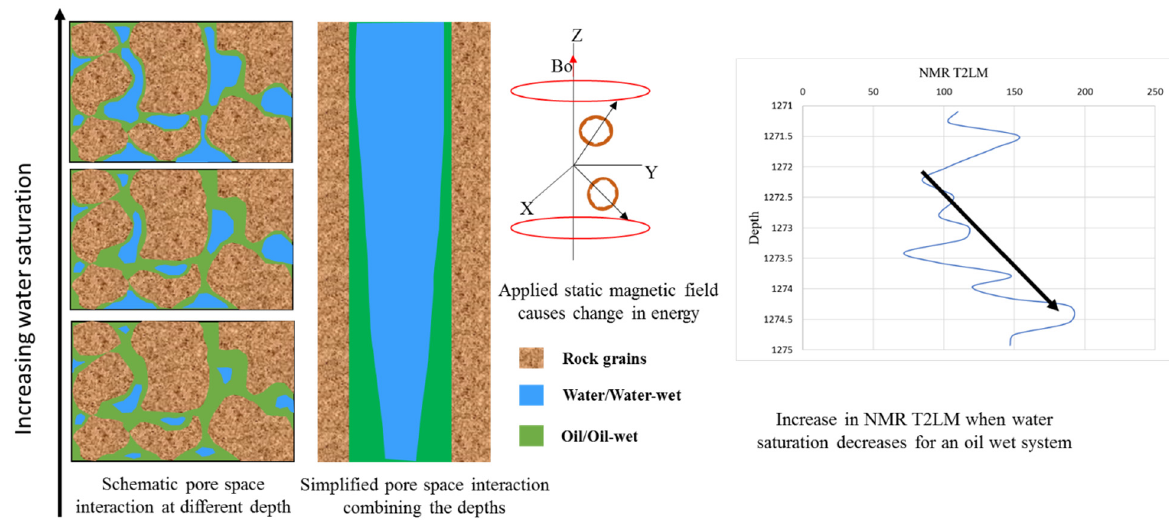
Figure 7. Schematic illustration of NMR T 2 LM distribution as a function of water saturation in a water-wet condition.